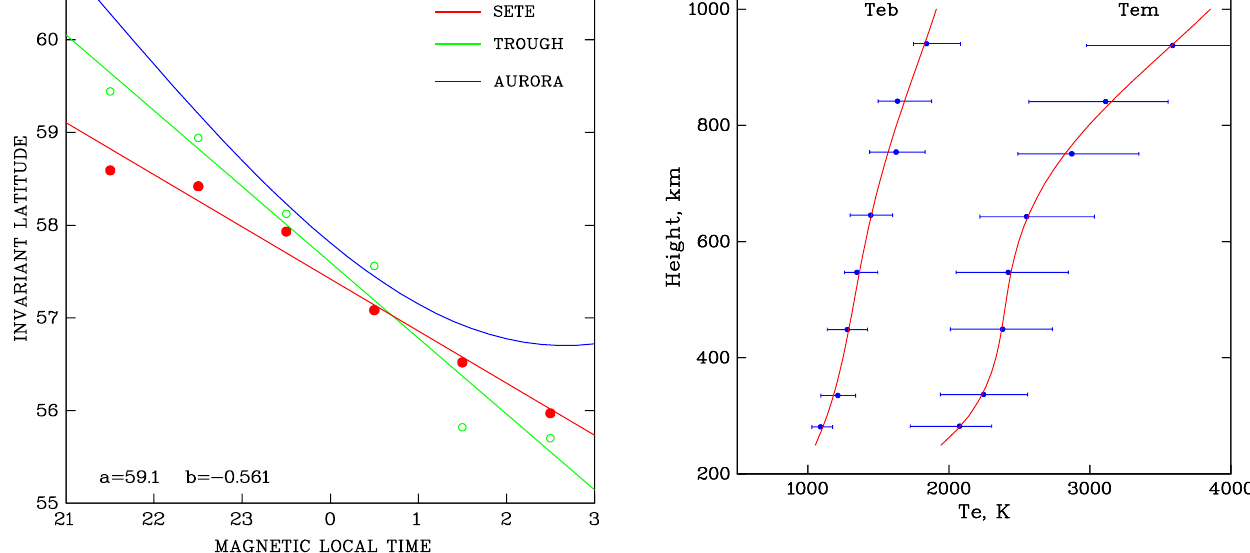
Fig. 7. Height variation of the electron temperature at subauroral latitudes. Compared are mean height profiles of the electron tem- perature as observed at the location of the equatorward boundary ( T eb ) and the maximum ( T em ) of the heating region. For each 100km-wide height interval, the median and the upper and lower quartiles of the temperature values were determined; see the blue dots and bars. Subsequently, fourth-order polynomials were fitted to the median values, and these are indicated by the red lines (see Eqs. (2) and